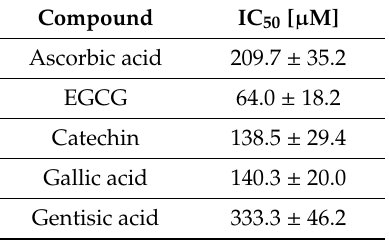
Figure 3. Attenuation of AAPH-generated intracellular ROS level by chosen antioxidants. The ROS level in the absence of any additive assumed as 100%. Endogenous ROS level in the absence of AAPH: 8.5 ± 0.3% of that found with AAPH. * p < 0.05, ** p < 0.01, *** p < 0.001 with respect to control (100%). Table 2. IC 50 values of chosen antioxidants for inhibition of ROS formation in erythrocytes. Mean ± SD, n ≥ 3.